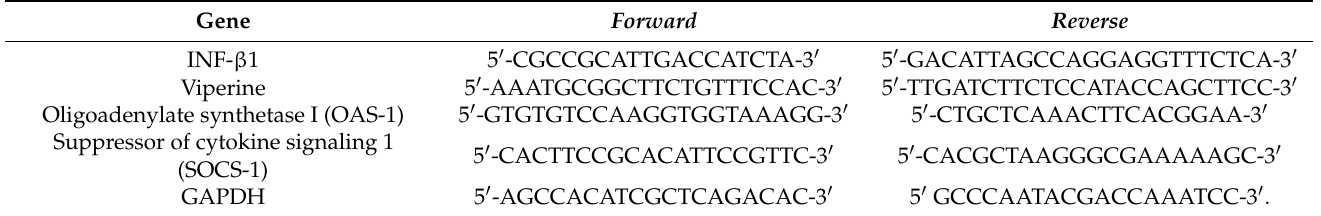
Table 1. The interferon- β and genes antivirals